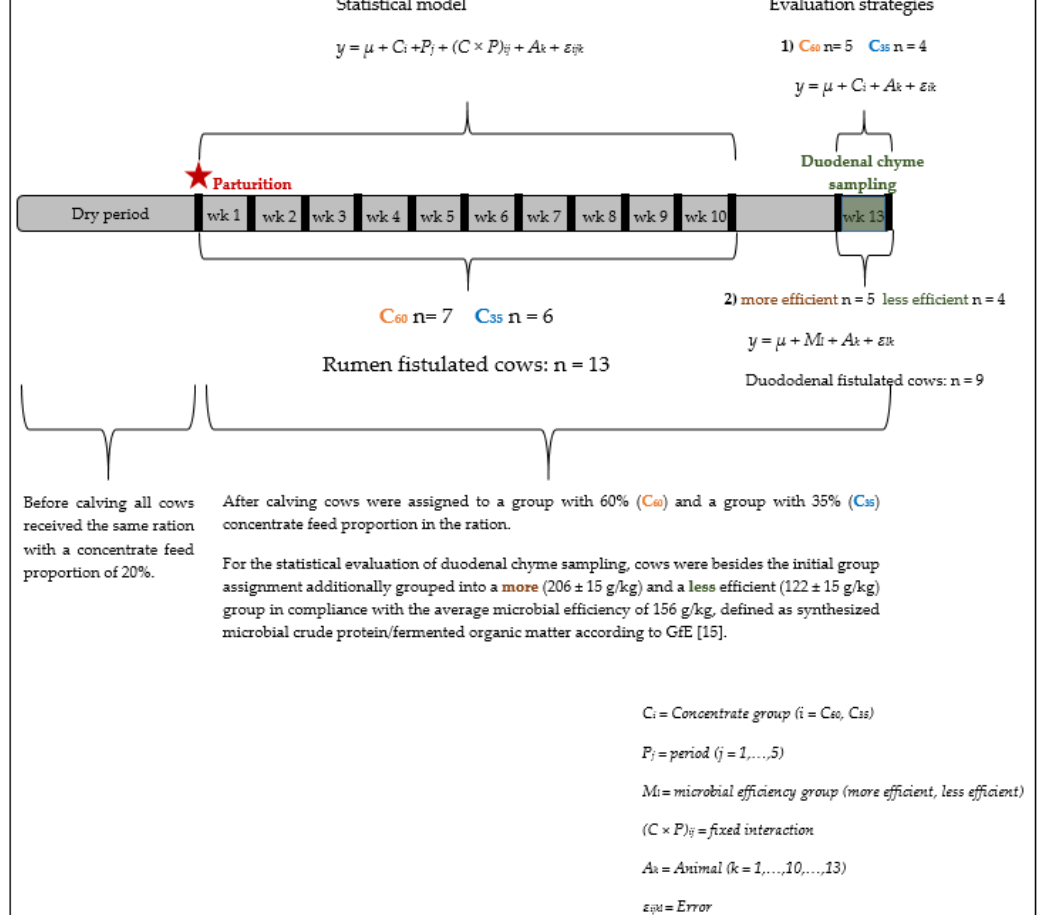
Figure 1. Experimental setup and statistical evaluations.